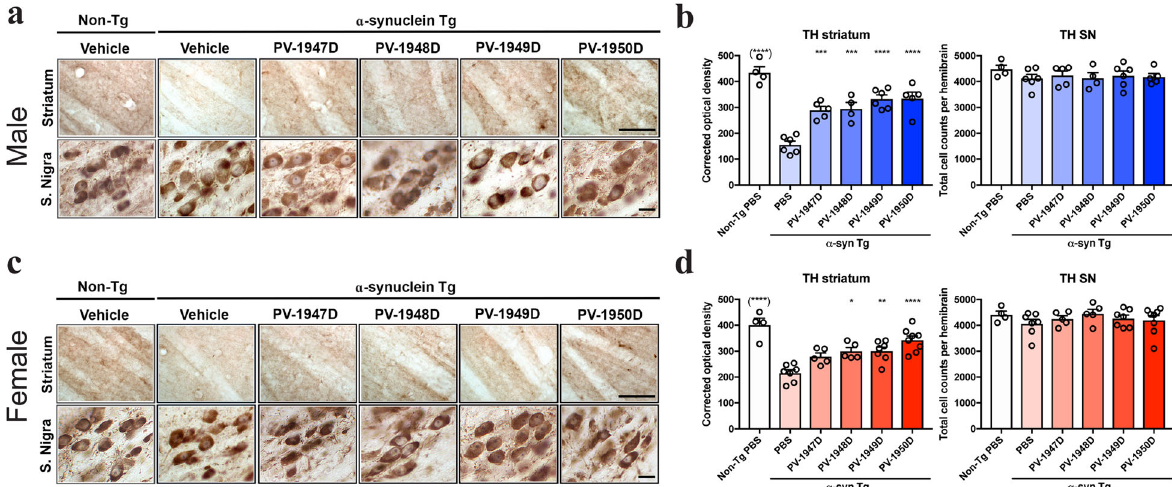
Fig. 6 Vaccination with MultiTEP-based DNA vaccines signi fi cantly ameliorated the loss of TH fi bers in h α -Syn Tg mice. a Representative images of brain sections from male mice immunostained with an antibody against the dopamine cell marker tyrosine hydroxylase (TH). From top to bottom, each panel illustrates the striatum and substantia nigra regions in non-Tg, and α Syn Tg mouse with the vehicle, PV-1947D, PV- 1948D, PV-1949D, and PV-1950D vaccination. b Image analysis of TH-positive fi bers expressed as corrected optical density in the striatum and total TH-positive cell counts per midbrain in substantia nigra of male mice. c Representative images of brain sections of female mice of immunostained with an antibody against TH. Each panel illustrates from top to bottom the striatum and substantia nigra in non-Tg, and α Syn Tg mouse with a vehicle, PV-1947D, PV-1948D, PV-1949D, and PV-1950D vaccination. d Image analysis of TH-positive fi bers expressed as corrected optical density in striatum and total TH-positive cell counts per midbrain in substantia nigra of female mice. The scale bar is 100 µm for Striatum and 10 µm for S. Nigra. * p < 0.05, ** p < 0.01, *** p < 0.001, **** p <